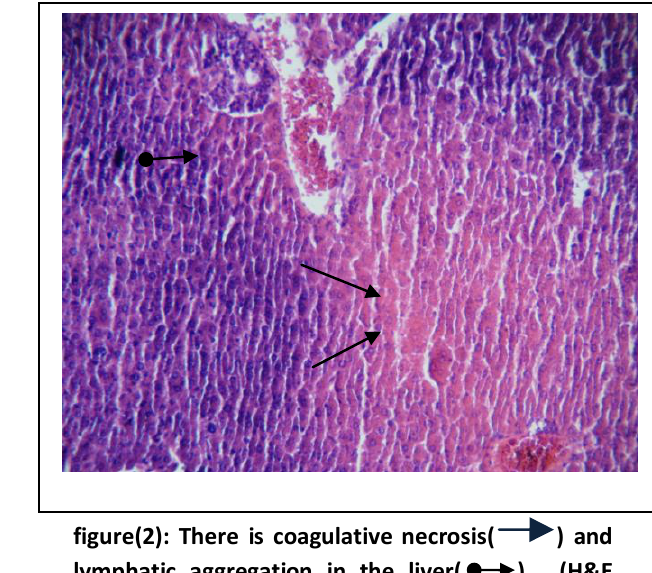
Figure (1): There is odema( ), congestion( ) in the lung. (H&E ×10).